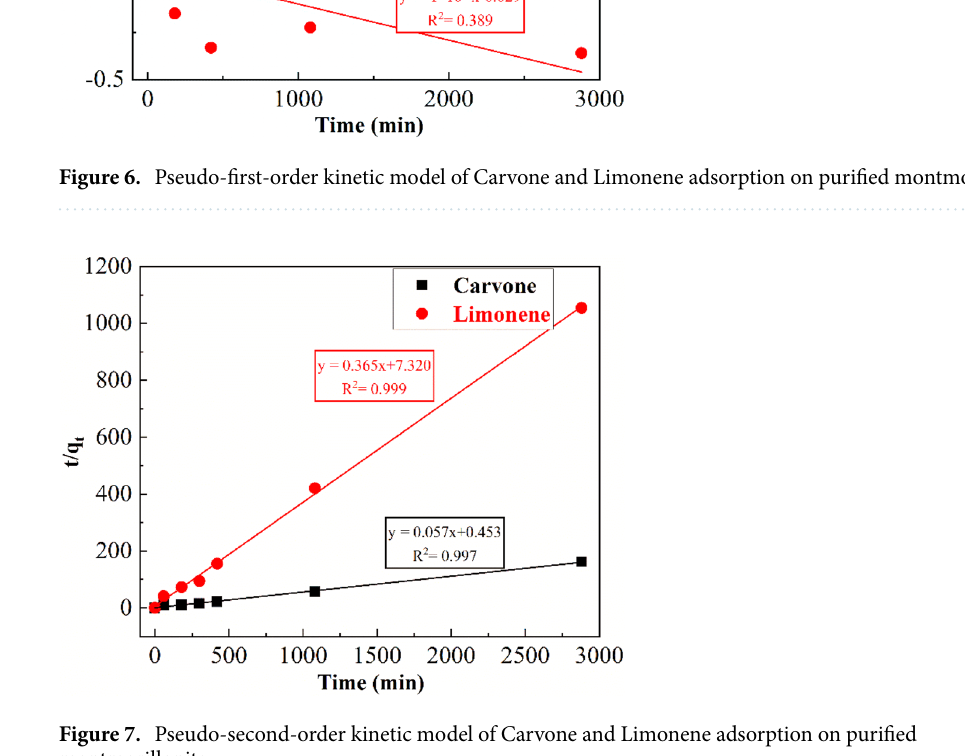
Pseudo-second-order kinetic